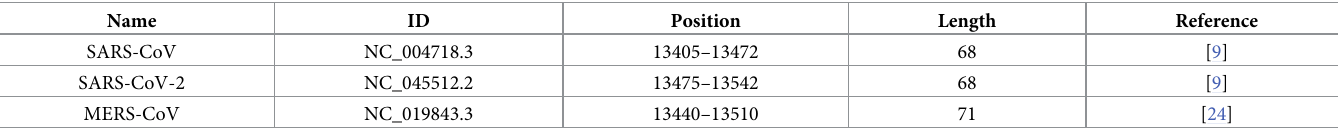
Table 1. List of viral sequences with their NCBI accession ID, position of frameshifting structure, length, and their reference.